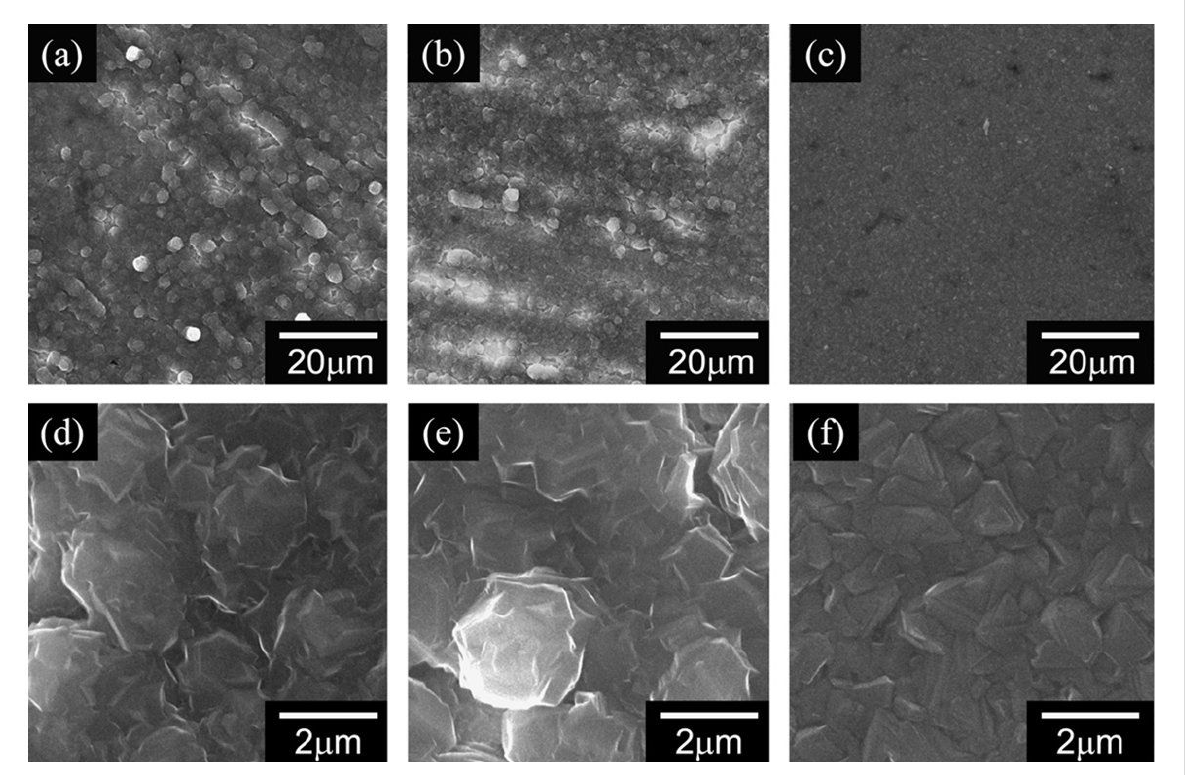
Figure 2: SEM images of the electrodeposited magnesium (a) 500×, 0.5 mA cm − 2 , (b) 500×, 1.0 mA cm − 2 , (c) 500×, 2.0 mA cm − 2 , (d) 5000×, 0.5 mA cm − 2 , (e) 5000×, 1.0 mA cm − 2 , and (f) 5000×, 2.0 mA cm − 2 . Reprinted with permission from [13]. Copyright 2011